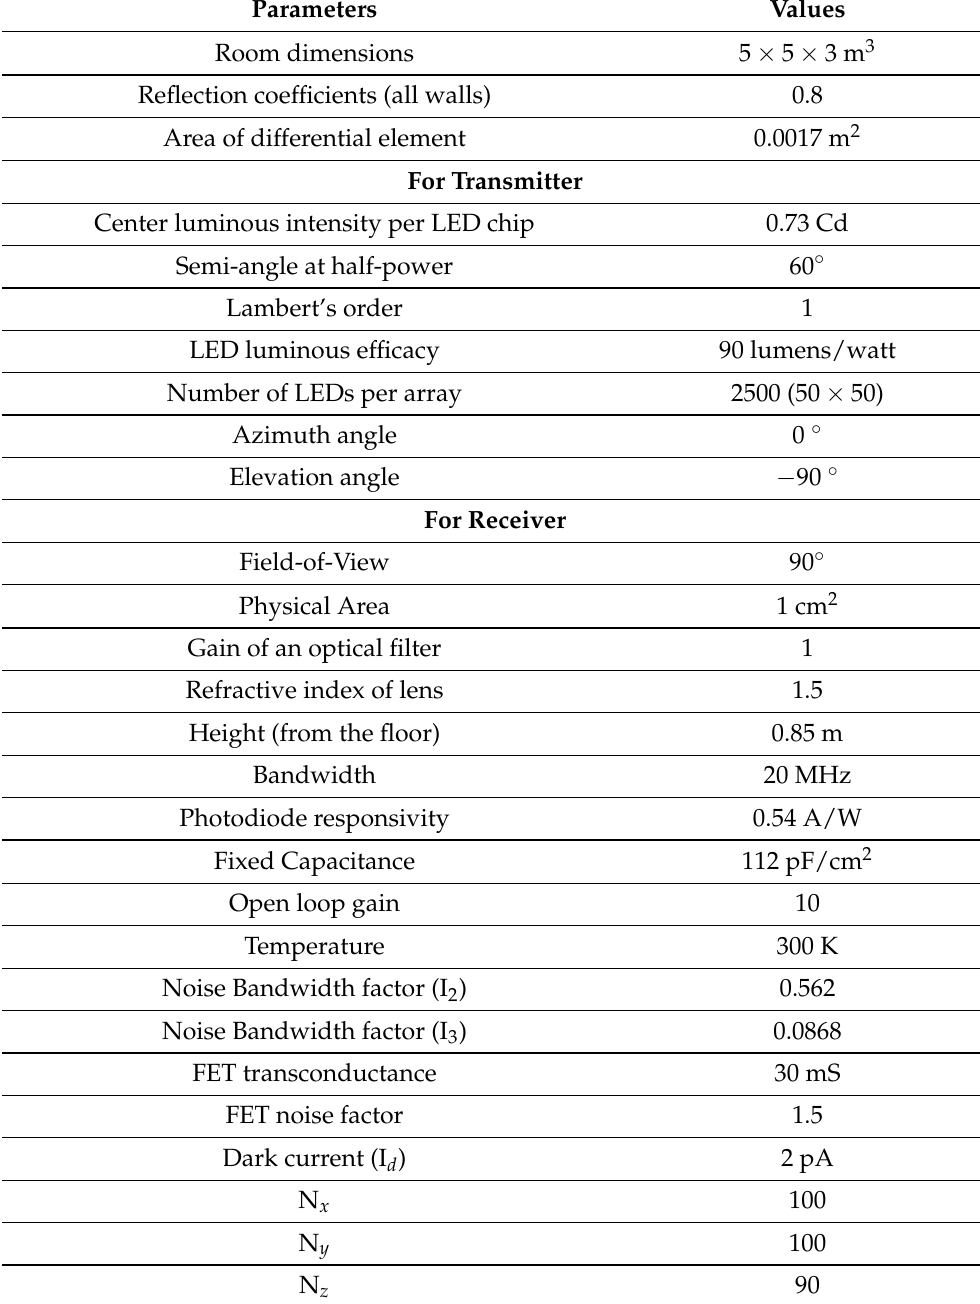
Table 1. Summary of Simulation Parameters